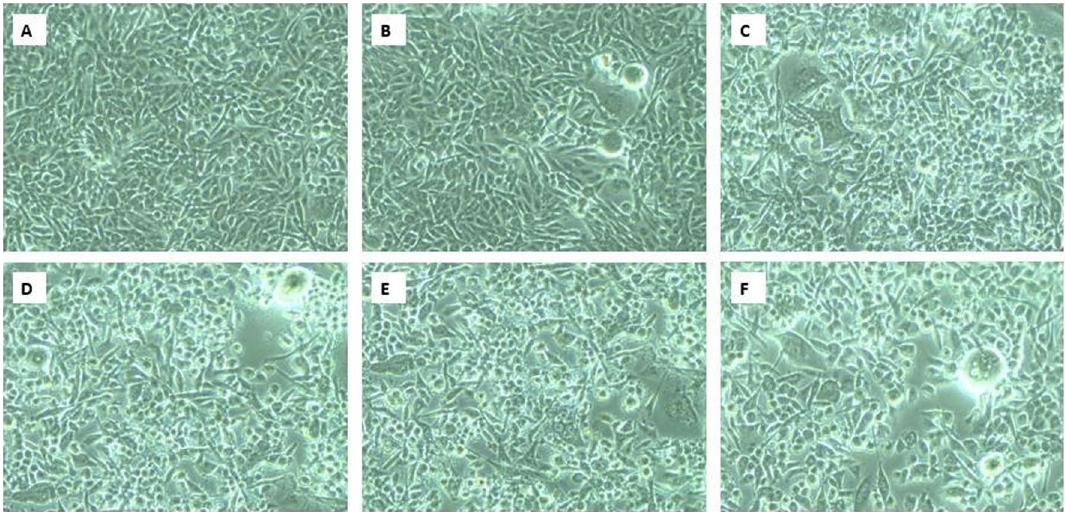
Figure 13. MTT Cell viability assay of the test compound exopolysaccharide isolated from the diatom Nitzschia palea on Human Lung Adenocarcinoma; ( A ) Control; ( B ) 15. 625 µg/mL; ( C ) 31.250 µg/mL; ( D ) 62.5 µg/mL; ( E ) 125 µg/mL; ( F ) 250 µg/mL.